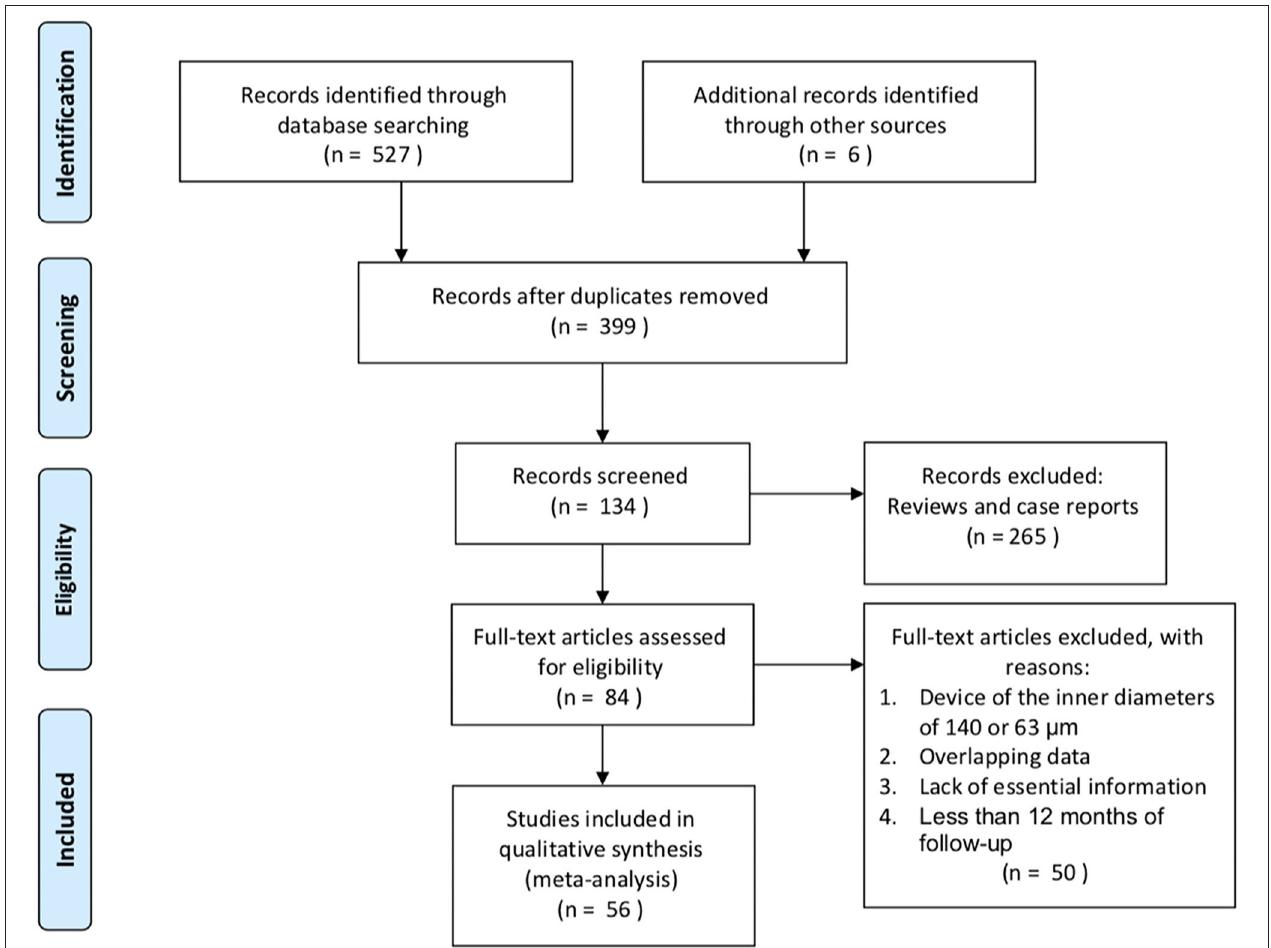
FIGURE 1 | Flow chart of included studies for the meta-analysis.